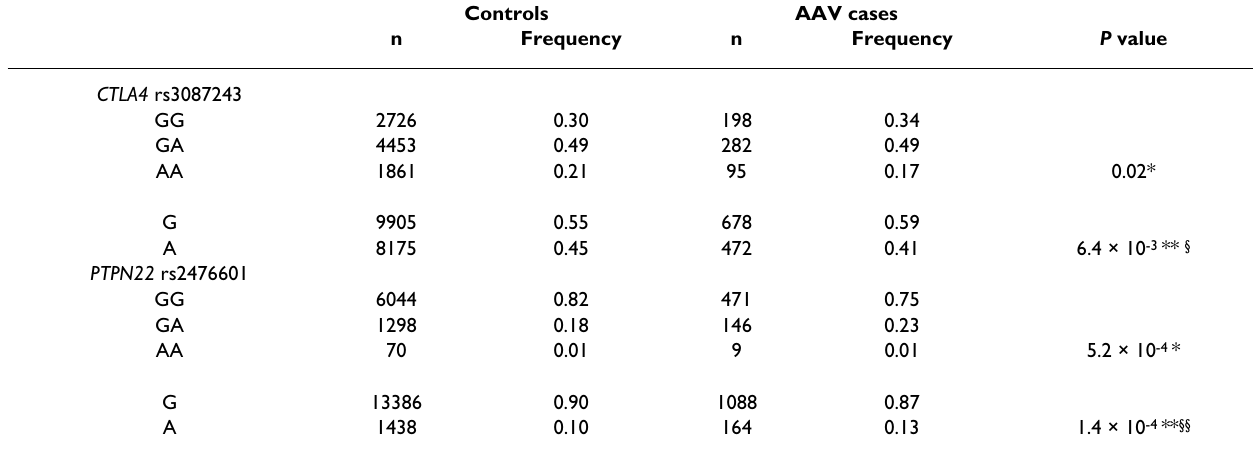
Table 2: Genotype and allele associations for CTLA4 rs3087243 and PTPN22 rs2476601 in AAV